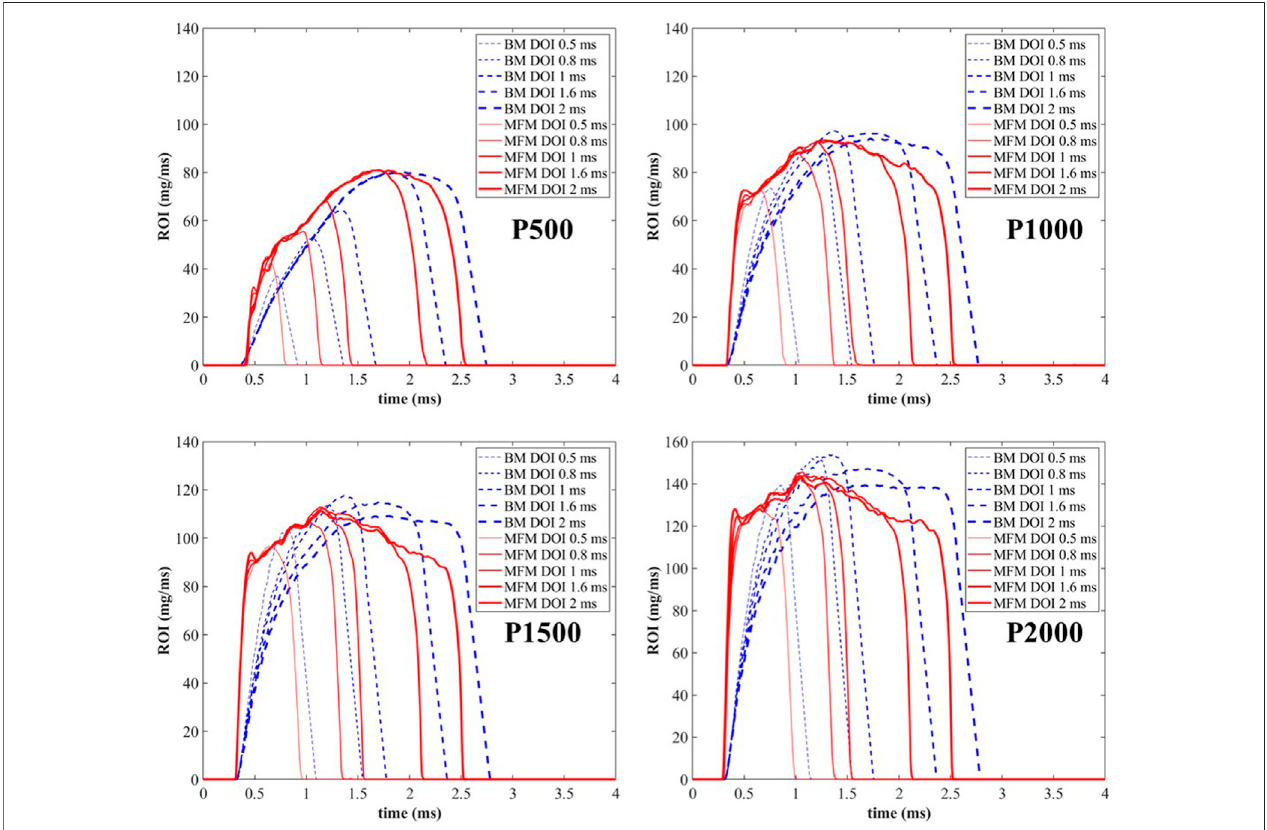
FIGURE 8 | Comparison of the ROI measurement with BM and MFM at different injection pressures and different DOIs.